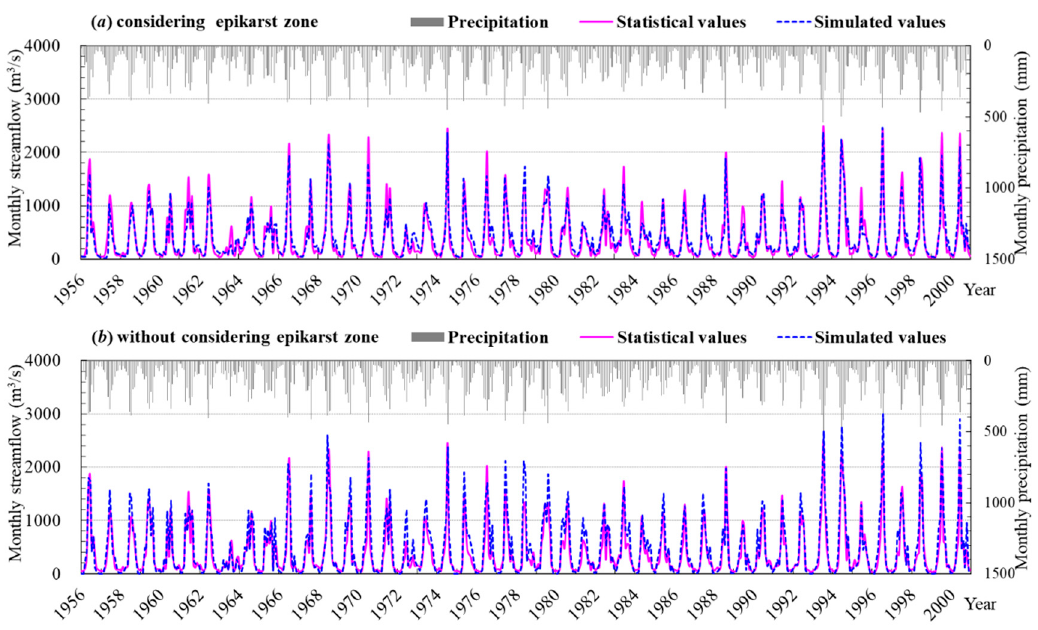
Figure 8. Comparison of simulated monthly discharge and the statistical values at Sancha station: ( a ) considering epikarst zone and ( b ) without considering epikarst zone.